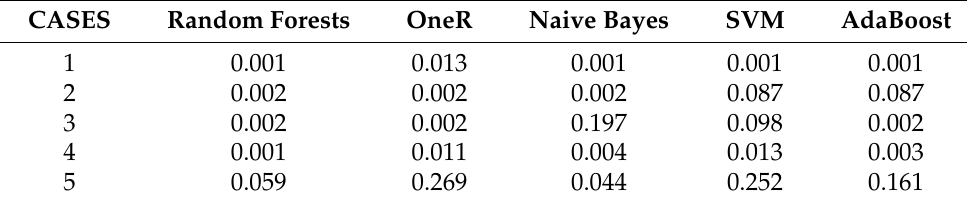
Table 7. False positive rate (%) for different case